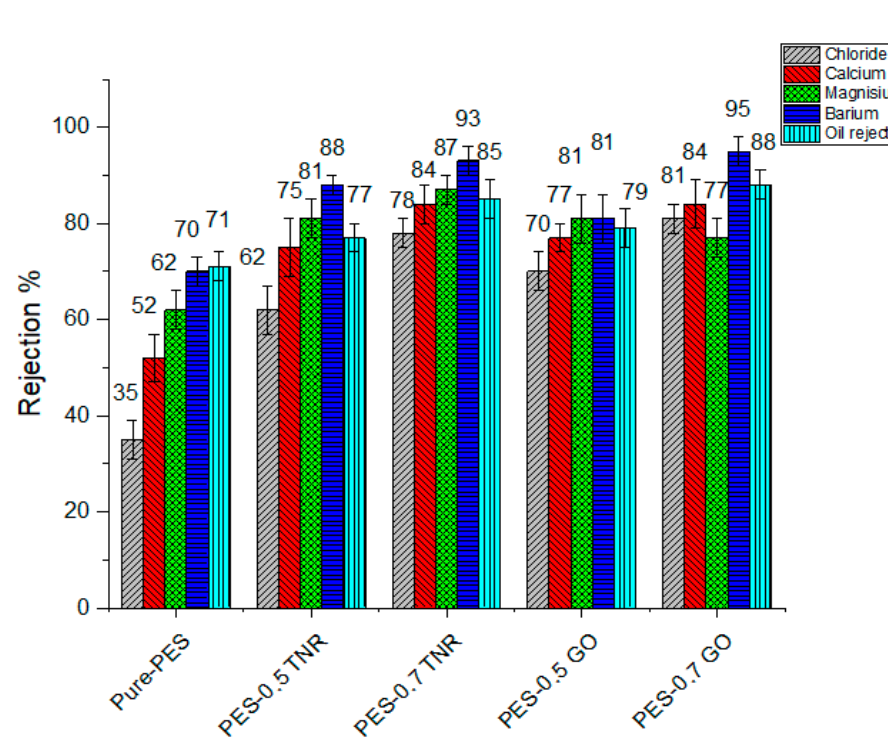
Figure 5. Salt and oil rejection of pure-PES, PES-TNR, PES-GO and NTR-7450 membranes.